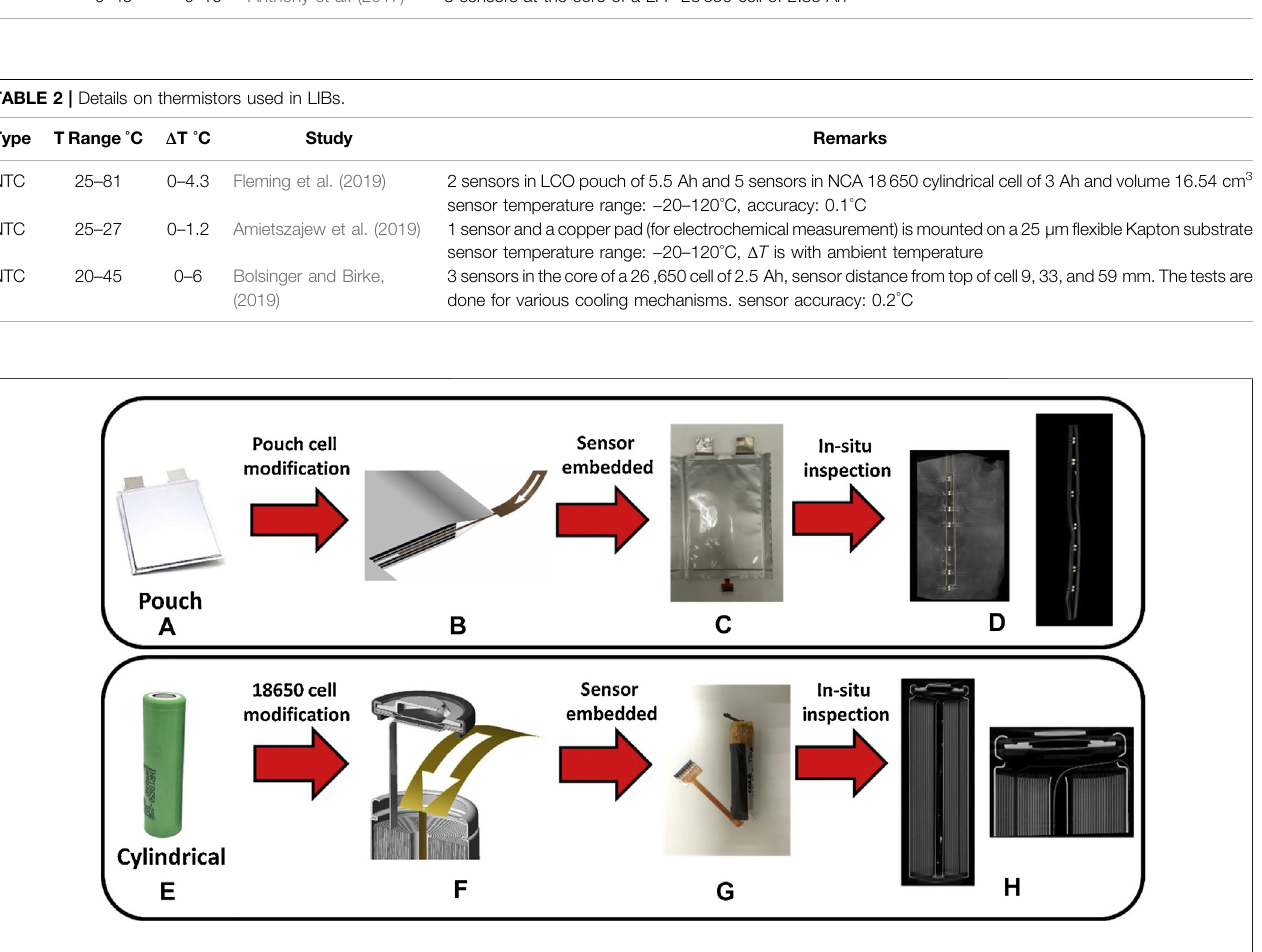
FIGURE 2 | Thermistor sensors embedded into pouch and cylindrical cells (Fleming et al., 2019; Panel 5, p. 41). (A) the pouch cell, (E) the cylindrical cell, (B,F) sensor inserted in the cell, (C,G) complete instrumented cell, (D,H) in-situ X-ray images of the cells post-modi fi cation, (CC BY-NC-ND 4.0).